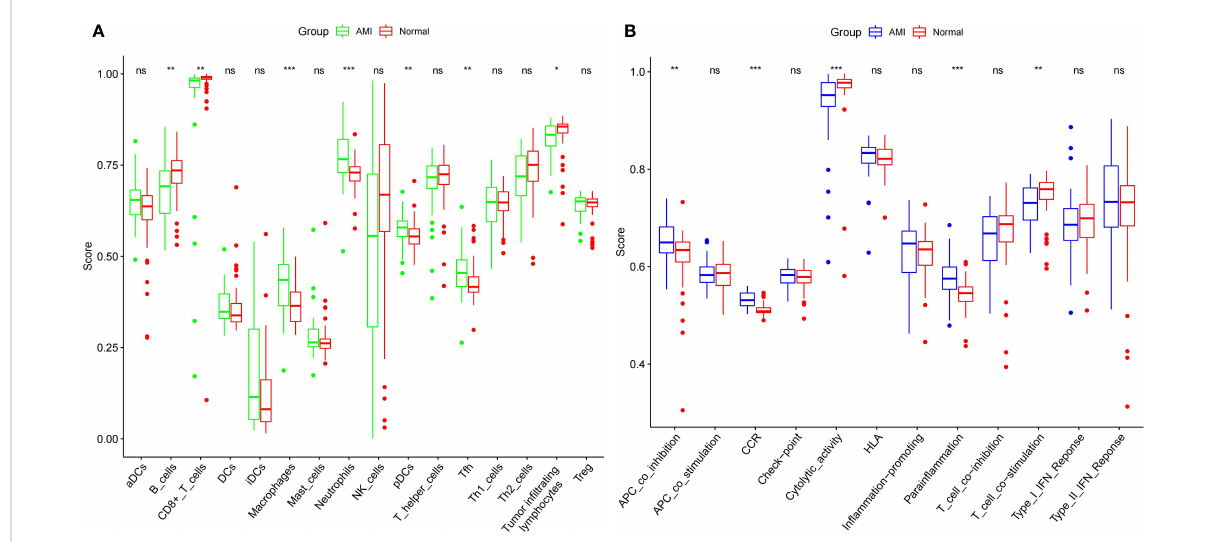
FIGURE 6 Comparison of expression of immune cells (A) and functions (B) between the MI patients and controls. *** indicates that the P-value is < 0.001, ** indicates that the P-value is < 0.01 * indicates P < 0.05, and “ ns ” indicates P < 1.